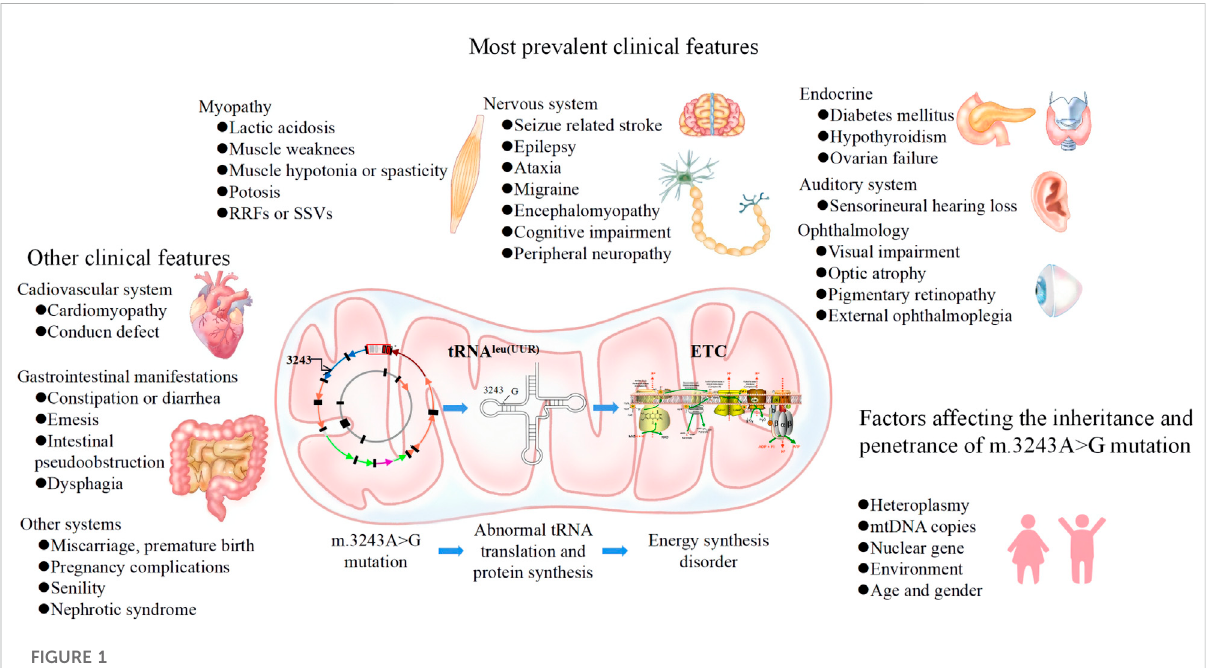
FIGURE 1 Abstract